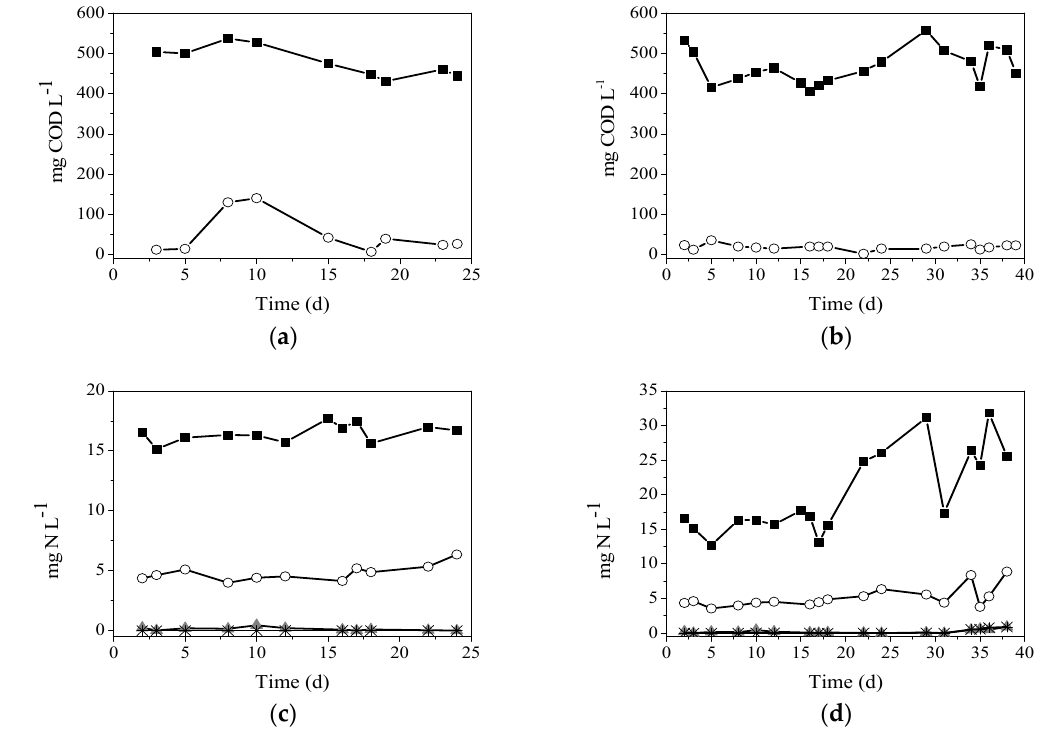
Figure 4. ( a , b ) COD concentrations in the influent ( ■ ) and effluent ( ○ ) in SBR I and SBR II, respectively. ( c , d ) Influent NH 4+ ‐ N concentrations ( ■ ), effluent NH 4+ ‐ N ( ○ ), NO 2 − ‐ N ( * ), and NO 3 − ‐ N ( ▲ ) in SBR I and SBR II, respectively. Table 1. Nitrogen removal efficiencies in SBR I and SBR II.